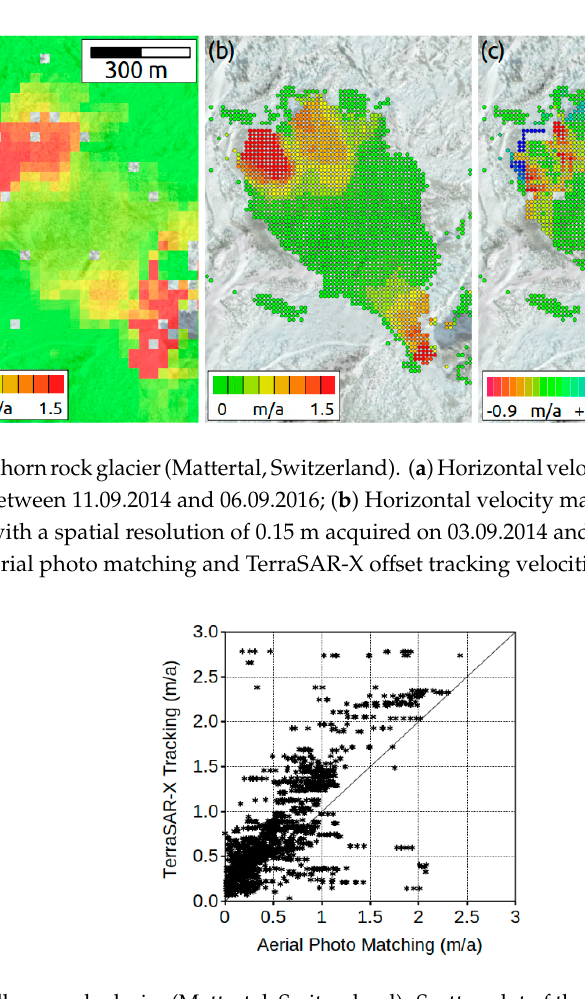
Figure 17. Distelhorn rock glacier (Mattertal, Switzerland). Scatter plot of the horizontal velocities from matching of aerial optical images between 03.09.2014 and 21.09.2017 and TerraSAR-X offset tracking between 11.09.2014 and 06.09.2016.